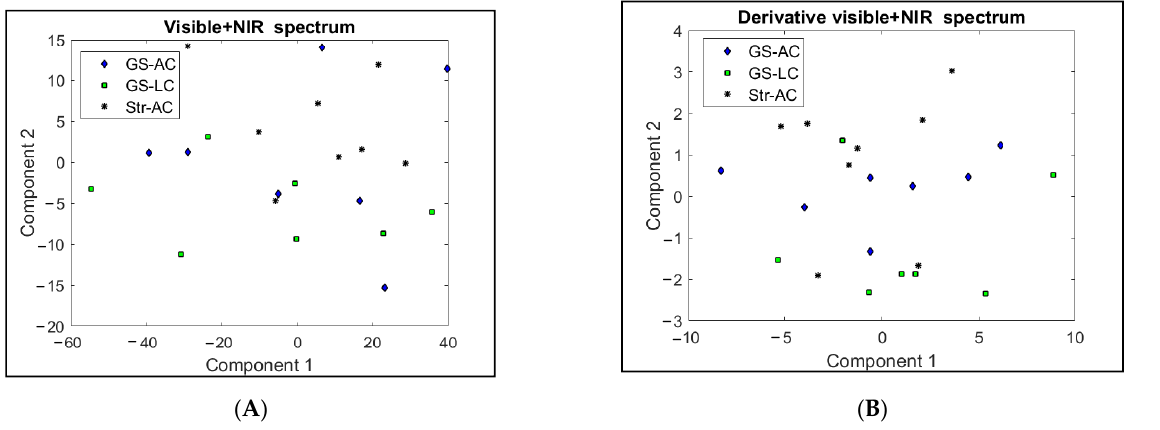
Figure 3. ( A , B ). Principal component score plots using data from the VIS + NIR spectra and its derivative as variables. GS-AC = ad libitum grass silage plus ad libitum concentrate diet; GS-LC = ad libitum grass silage plus limited concentrate diet; Str-AC = barley straw plus ad libitum concentrate diet.